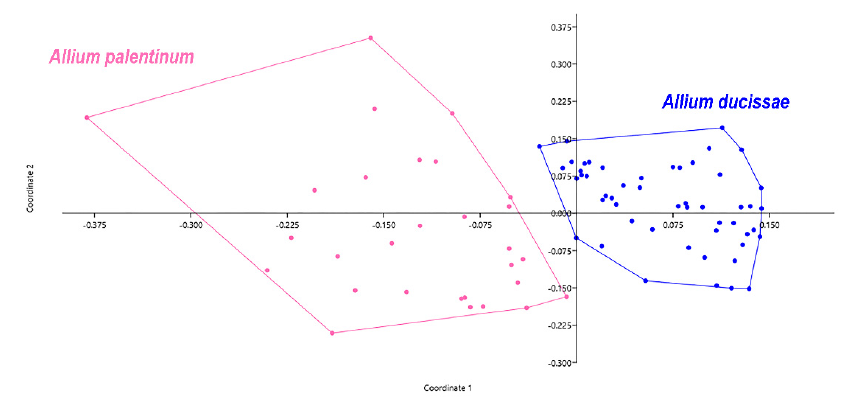
Figure 7. Principal coordinates analysis (PCoA) based on the distance matrix of Bray–Curtis dissimilarity. Scatter plot of first two principal coordinate axes based on 21 morphological characters and 80 specimens.